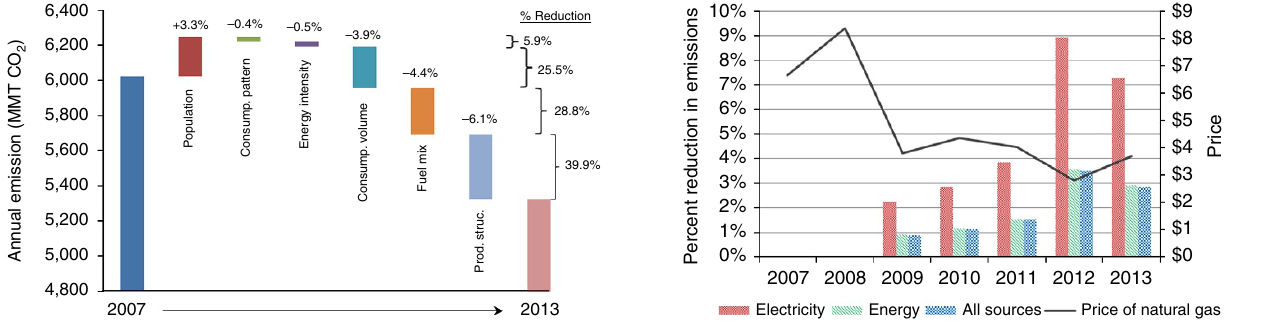
Figure 2 | Annual percentage reduction of US CO 2 emissions compared with 2007 levels due to fuel switching of natural gas for coal in electricity generation and annual natural gas prices. Forecasts are based on holding the emission rate from coal and natural gas constant at the 2007 level. Bases for comparison are annual emissions from all fossil-fuel generated electricity, all energy-related emissions and US emissions from all sources. As a share of the overall reduction of emissions from 2007 to 2013 of 10.3%, this method attributes 28.2% to greater use of natural gas in electricity